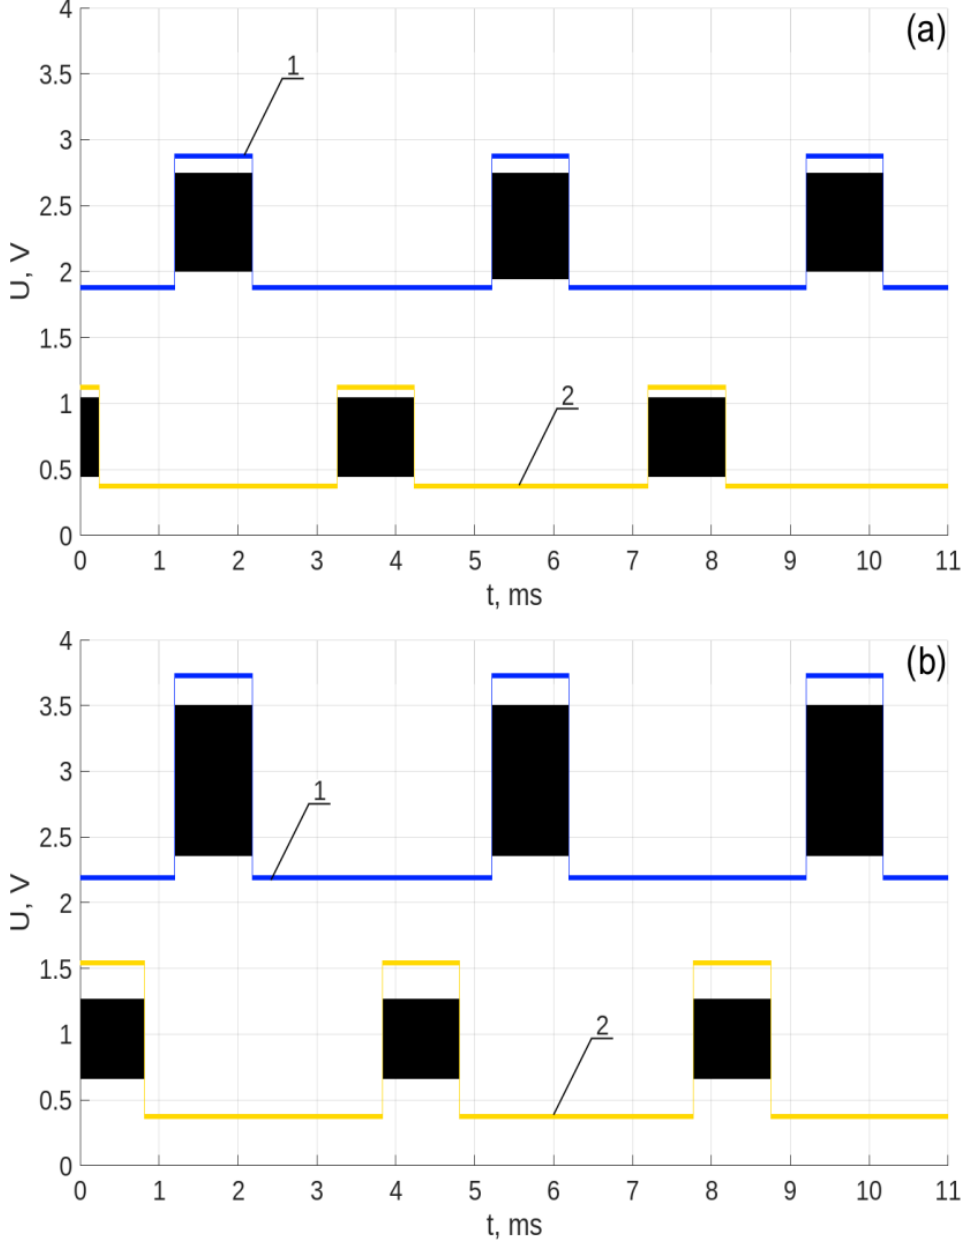
Figure 7. Rectangular pulses for the transmission of digits in numbers as a sequence of command codes: graph 1 at the input to 2, graph 2 at the output 3. Studies are presented for various values of L in km: ( a ) − 200; ( b ) − 250.